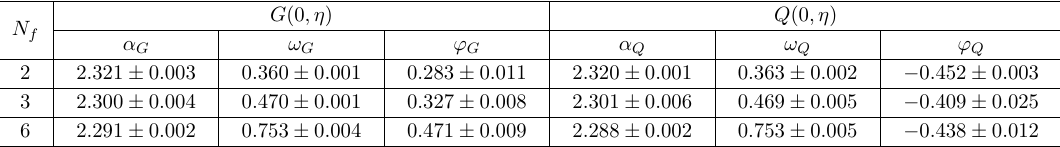
Table 1 . The resulting intercept (cid:11) , frequency ! , and initial phase ’ , for the gluon and quark polarized dipole amplitudes G (0 ; (cid:17) ) and Q (0 ; (cid:17) ) at N f = 2 ; 3 ; 6 and N c = 3. equations generates oscillations. While the absolute values of Q ( s